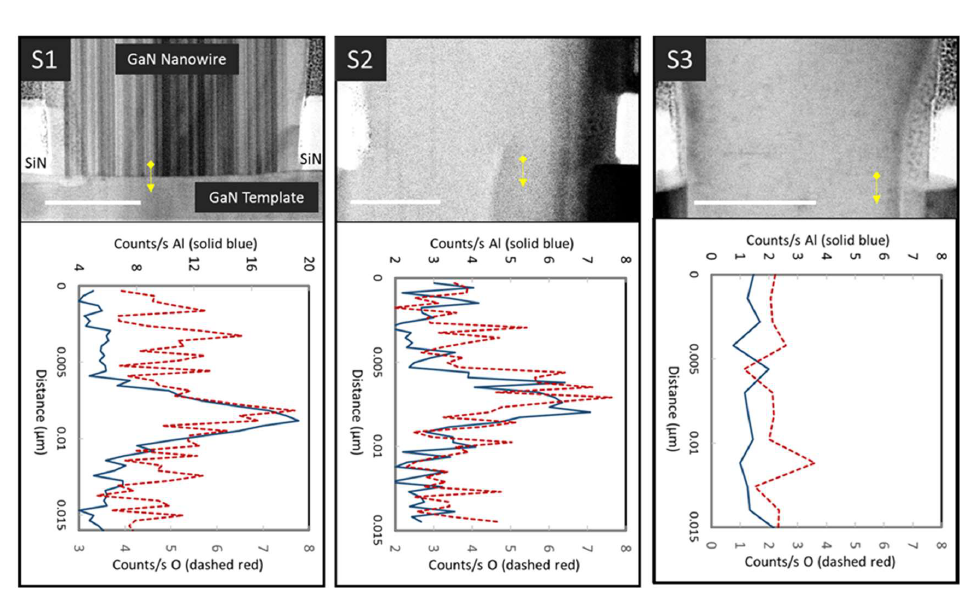
Figure 1. Typical bright-field STEM images and EDS line scan data from the regrowth interface of nanowires in growth runs S1, S2, and S3. The scale bars are 100 nm. The vertical lines running through the NWs are polarity inversion domains, as verified by direct lattice imaging. The arrow overlaying each STEM image depicts an example EDS line scan location. Data from one such EDS scan are plotted below each image; additional scans with similar results were taken at multiple positions across each NW. Table 1. Summary of TEM and L-APT measurements of the regrowth interface in three different selective-area nanowire growth runs, plus the SiN mask region from sample S1. Each acid treatment was applied prior to NW growth. The TEM EDS counts per second above background represent an average of the maximum background-corrected counts in several EDS line scans of 4 or 5 NWs (or multiple locations in the SiN mask region). The L-APT ideal c -plane monolayer fraction ( f ML ) results are from one regrowth interface sample each.